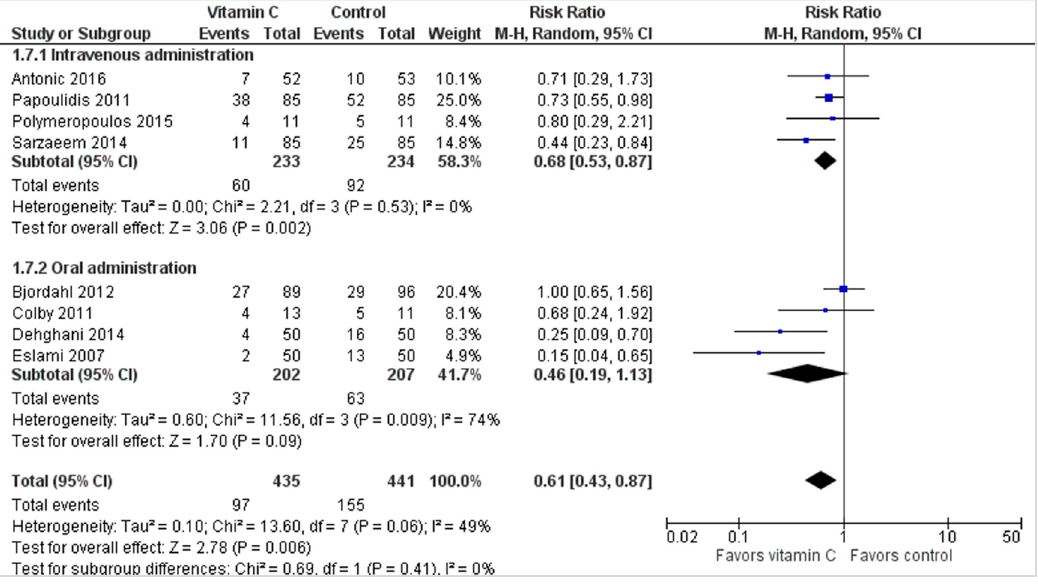
Figure 11. Incidence of atrial fibrillation: subgroup analysis—influence of administration route.